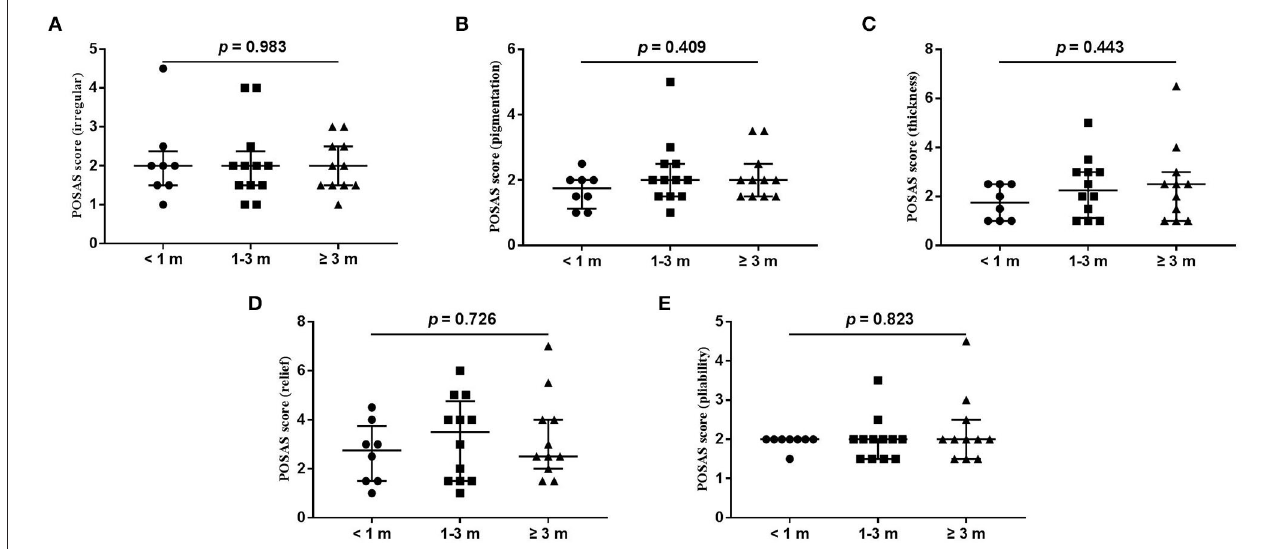
FIGURE 5 | Each item of POSAS observer scale. (A) vascularization; (B) pigmentation; (C) thickness; (D) relief; (E) pliability. Numbers of patients in groups of < 1 month, 1–3 months, and ≥ 3 months were 8, 11, and 12,